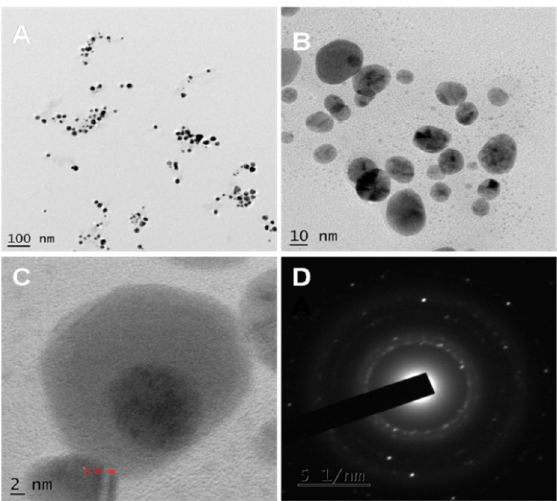
Figure 3. ( A ) TEM micrographs of green synthesized spherical AgNPs. ( B ) Green synthesized AgNPs in higher magnification ( C ) HRTEM image showing the interplanar distance of 0.24 nm ( D ) SAED pattern showing crystallinity of the AgNPs.